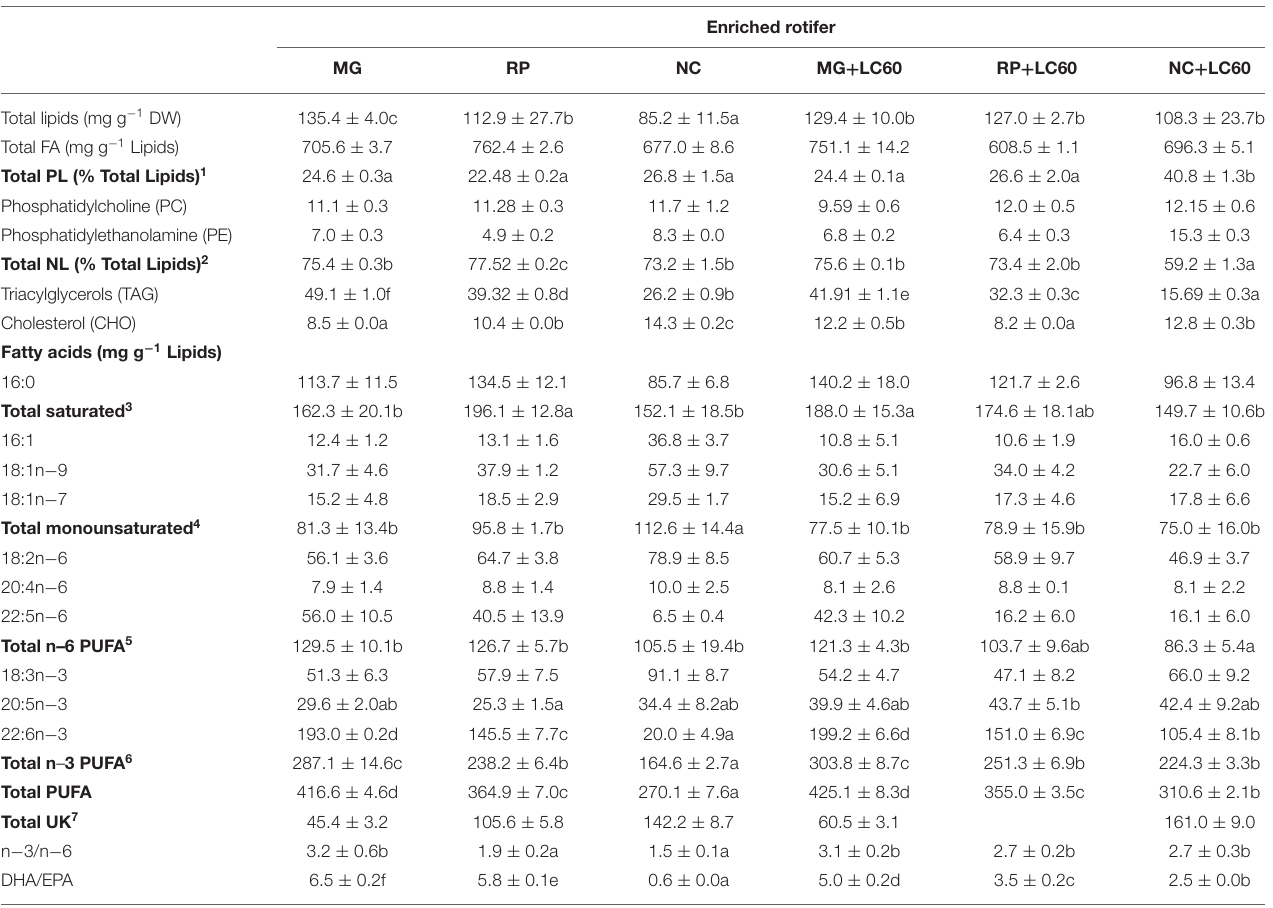
TABLE 2 | Total lipid and main lipid class content and fatty acid composition of the enriched rotifers used for larval feeding: Larviva Multigain (MG), Red Pepper (RP), Concentrated Nannochloropsis (NC), and marine phospholipids